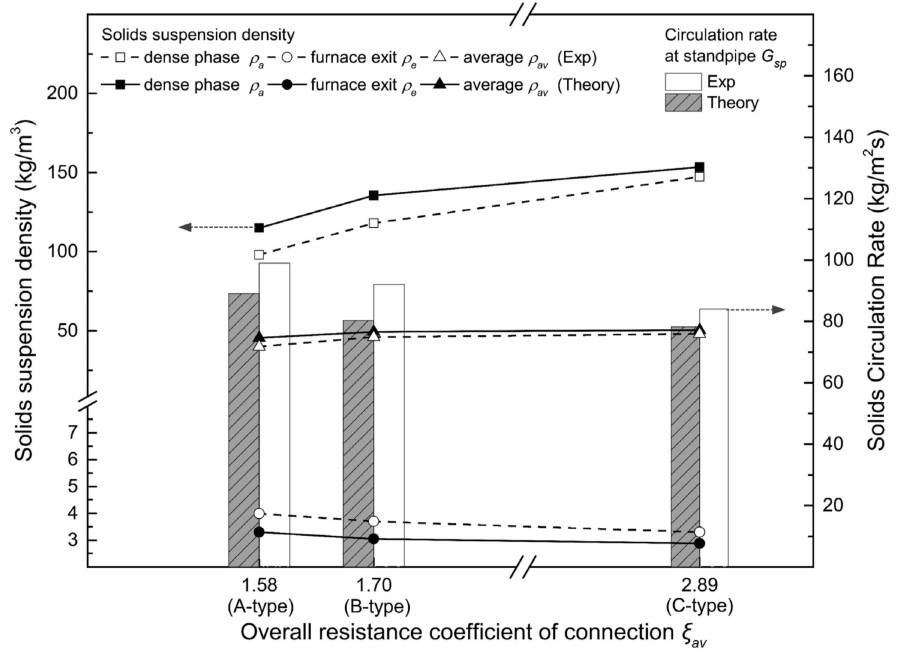
Figure 8. Solids suspension density and G sp in different connection